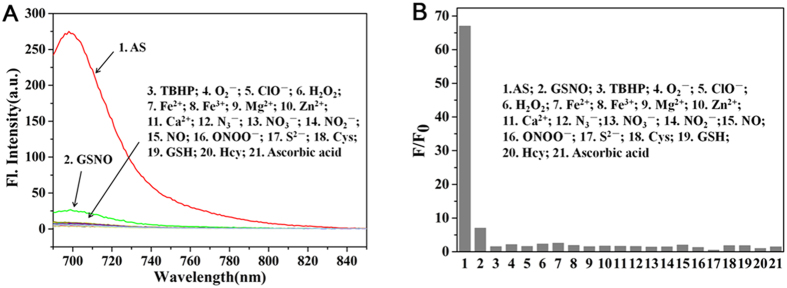
Fluorescence response of probe 1 (10 μM) after 30 min of incubation with various analytes: 1. AS; 2. GSNO; 3. TBHP; 4. KO2; 5. ClO−; 6. H2O2; 7. Fe2+; 8. Fe3+; 9. Mg2+; 10. Zn2+; 11. Ca2+; 12. N3−; 13. NO3−; 14. NO2−; 15. NO; 16. ONOO−; 17. S2−; 18. Cys; 19. GSH 20. Hcy; 21. Ascorbic acid. ([AS] = 100 μM; [analytes] = 200 μM).